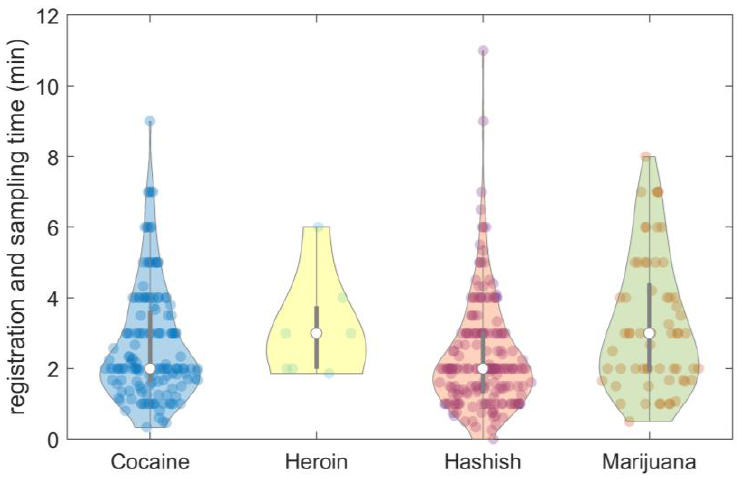
Figure 3. Violin plot of registration and sampling time for the most frequent types of street seizures.